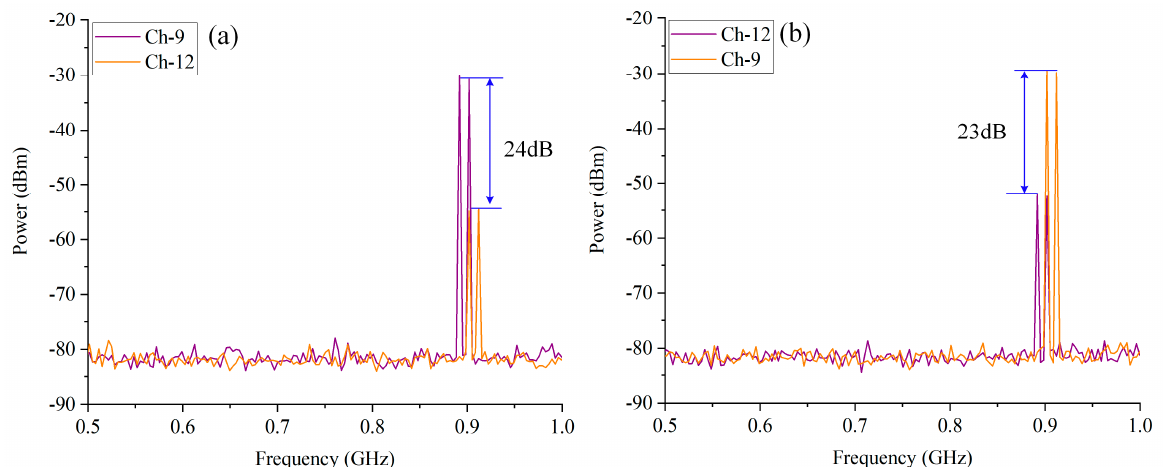
Figure 6. Electrical spectra of ( a ) Ch − 9 as the desired channel and ( b ) Ch − 12 as the desired channel.